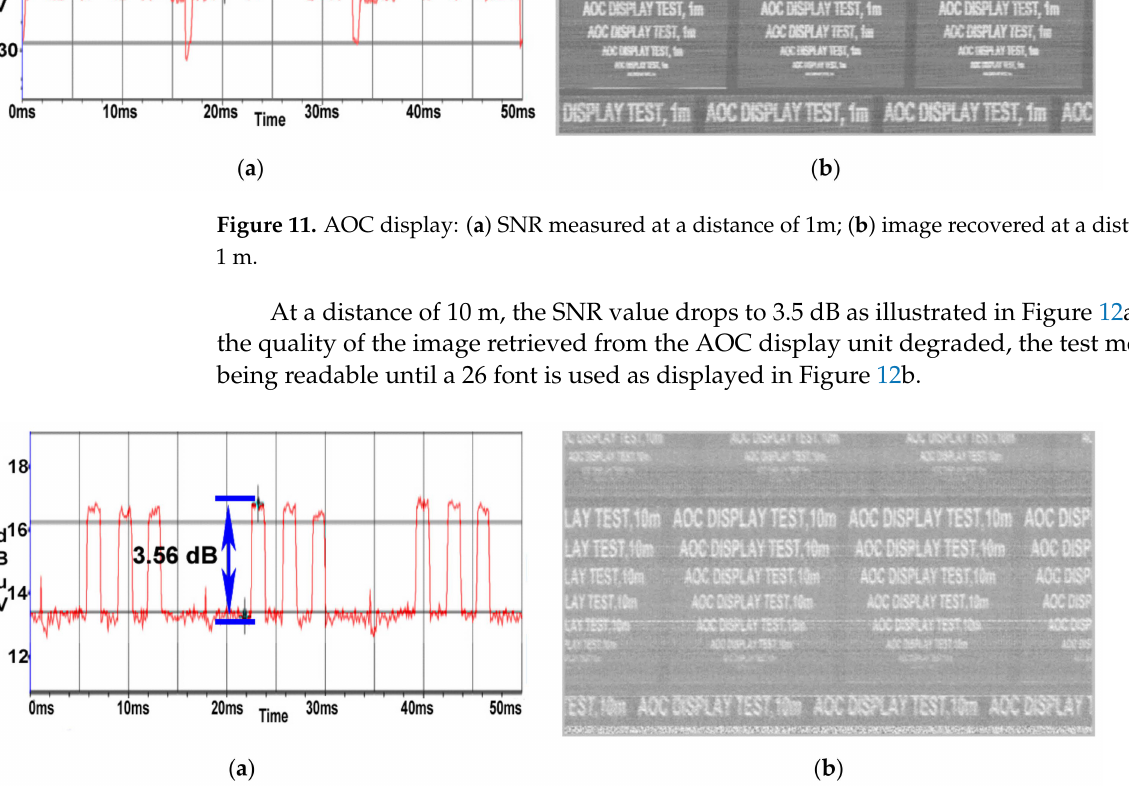
Figure 12. AOC display: ( a ) SNR measured at a distance of 10 m; ( b ) image recovered at a distance of 10 m.